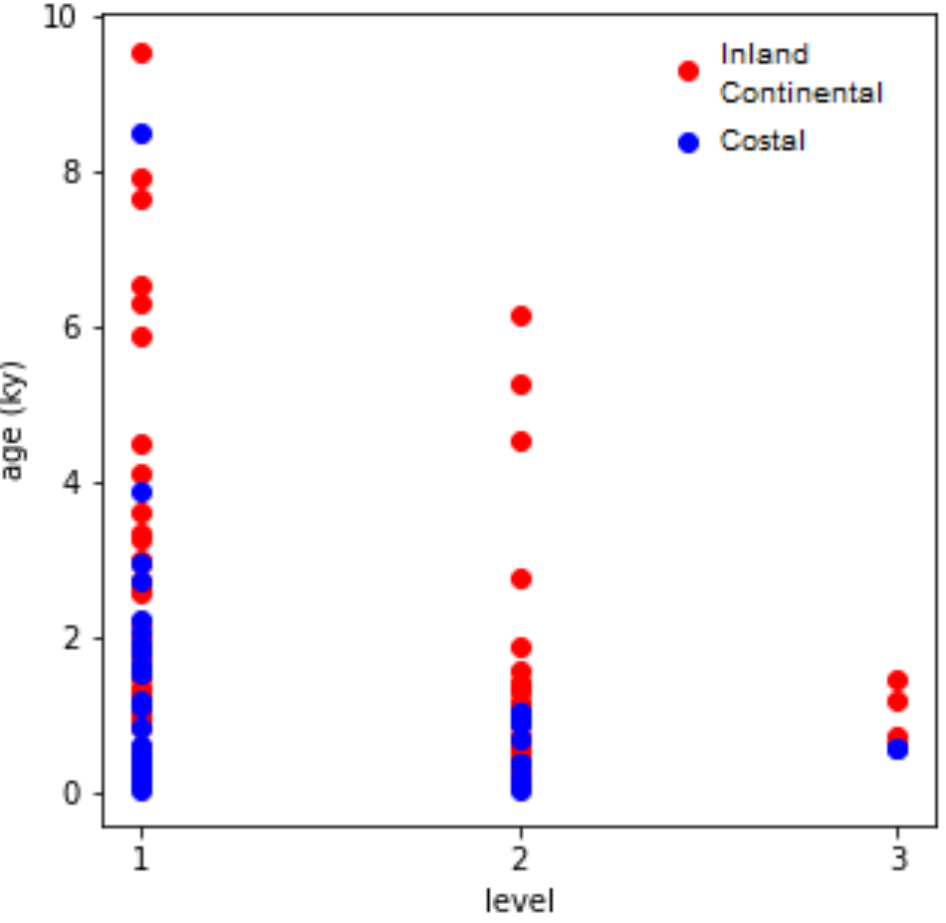
Figure 4. Age distribution of samples and their terrace levels. Each dot represents a sample with its age and terrace level (1, 2, and 3). Coastal samples are younger and present a smaller age distribution than continental samples.